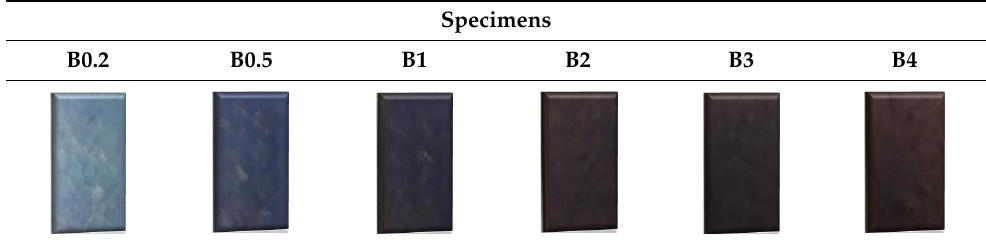
Table 9. Color parameters of specimens dyed with dye Disperse blue 27 (DB27).